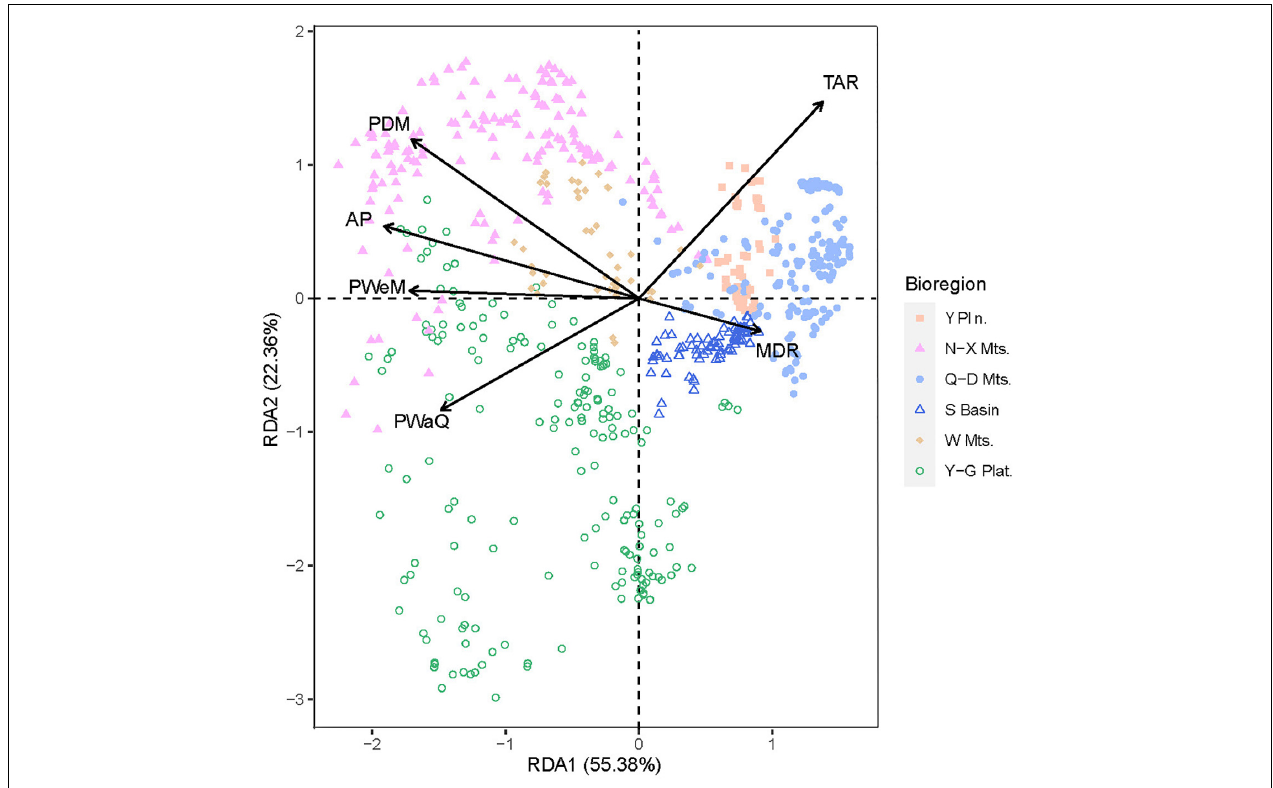
FIGURE 6 | Ordination plot for a redundancy analysis (RDA) of species richness with several explanatory environmental variables. Sample points are grouped and colored by bioregion.